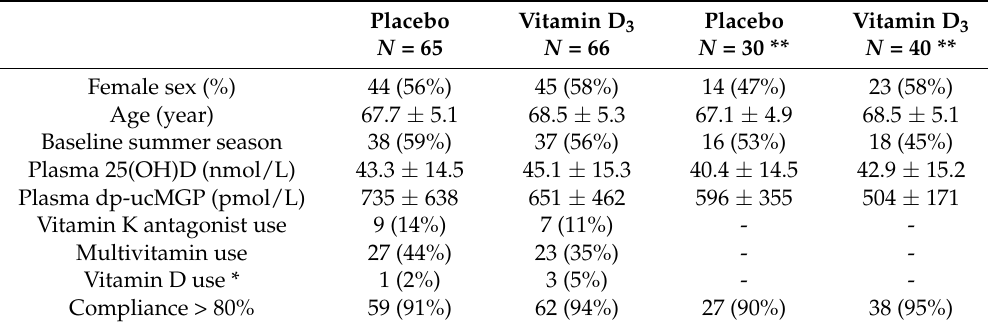
Table 1. Baseline characteristics of D-Vitaal study participants.